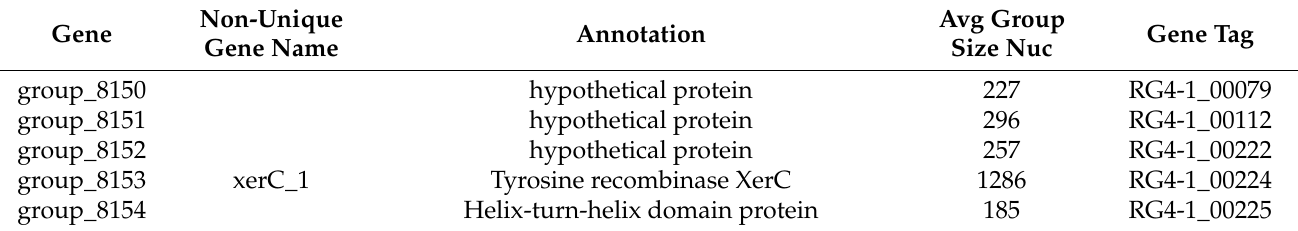
Figure 2. The analysis pipeline for strain-specific primer design corresponding to the three B. longum strains ( A ) and the pangenome readout ( B ). Table 4. Strain-specific genes identified by Roary for B. longum